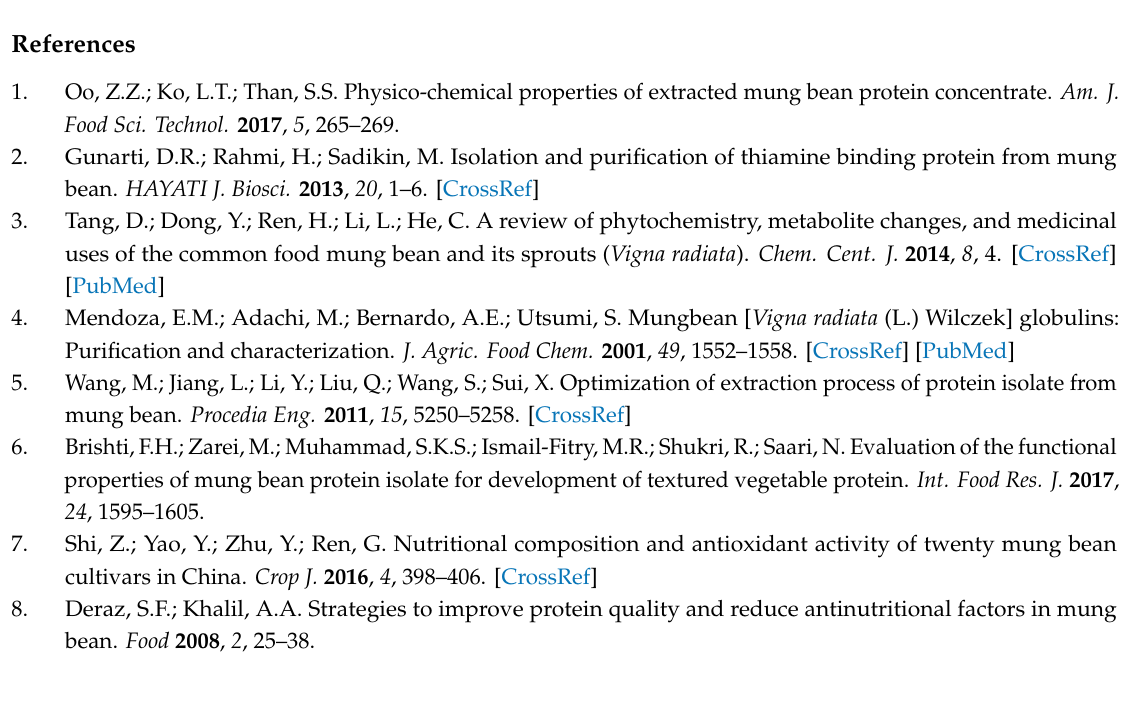
Table S1: Sequences, Functional Properties and Bioactivity of Mung Bean Albumin Hydrolysates Derived from Gastrointestinal Enzymatic Hydrolysis; Table S2: Sequences, Functional Properties and Bioactivity of Mung Bean Albumin Hydrolysates Derived from Thermolysin Enzymatic Hydrolysis; Figure S1: Antioxidant Potential of Mung Bean Albumin Hydrolysates at Various Hydrolysis Times from Two Di ff erent Enzyme Schemes. The star marks the time point at which pancreatin was added 2 h after pepsin. These results were obtained from hydrolysates derived from an average of 576 µ g / mL of mung bean